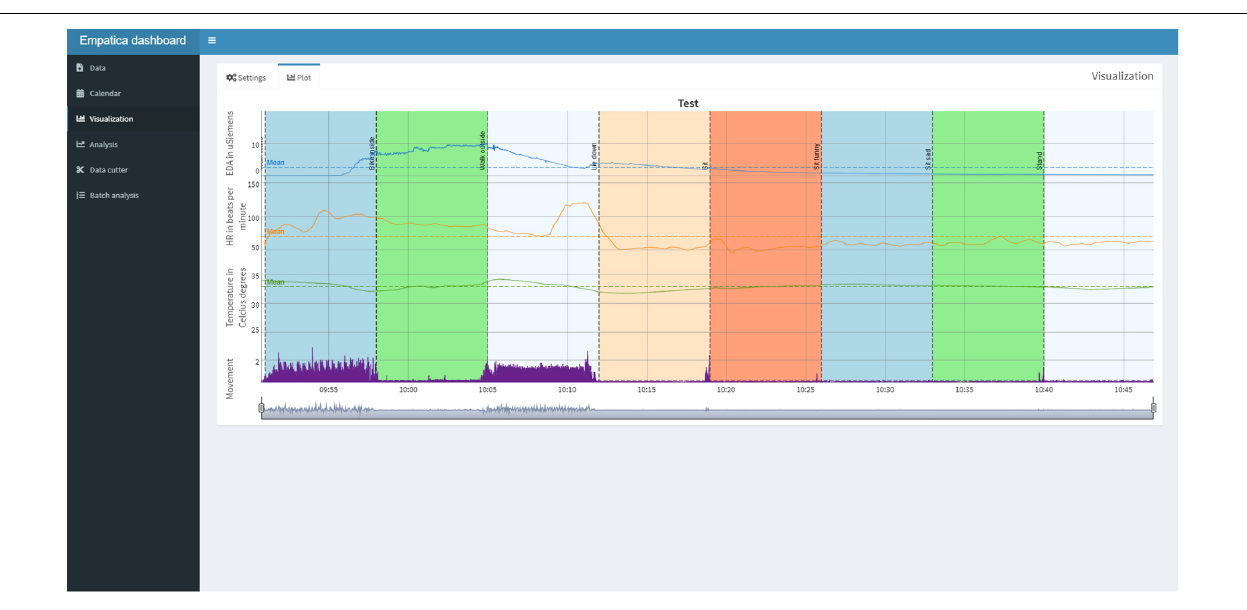
FIGURE 6 | The Plot Tab can be used to visualize the physiological signals and synchronize them with the calendar events. A session is displayed for approximately 1 h, in which one of the authors undertakes eight activities, each lasting 7 min, to indicate the differences in physiological reactivity during various activities and illustrates differences in physiological